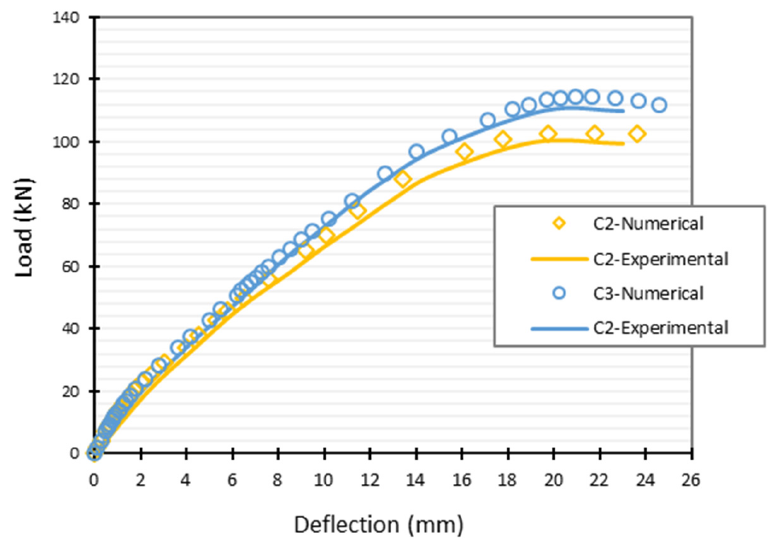
Figure 4. CFRP distribution for the haunched beams.